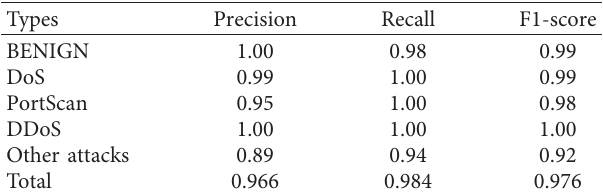
Figure 7: Loss-accuracy change rate. Table 3: Classification